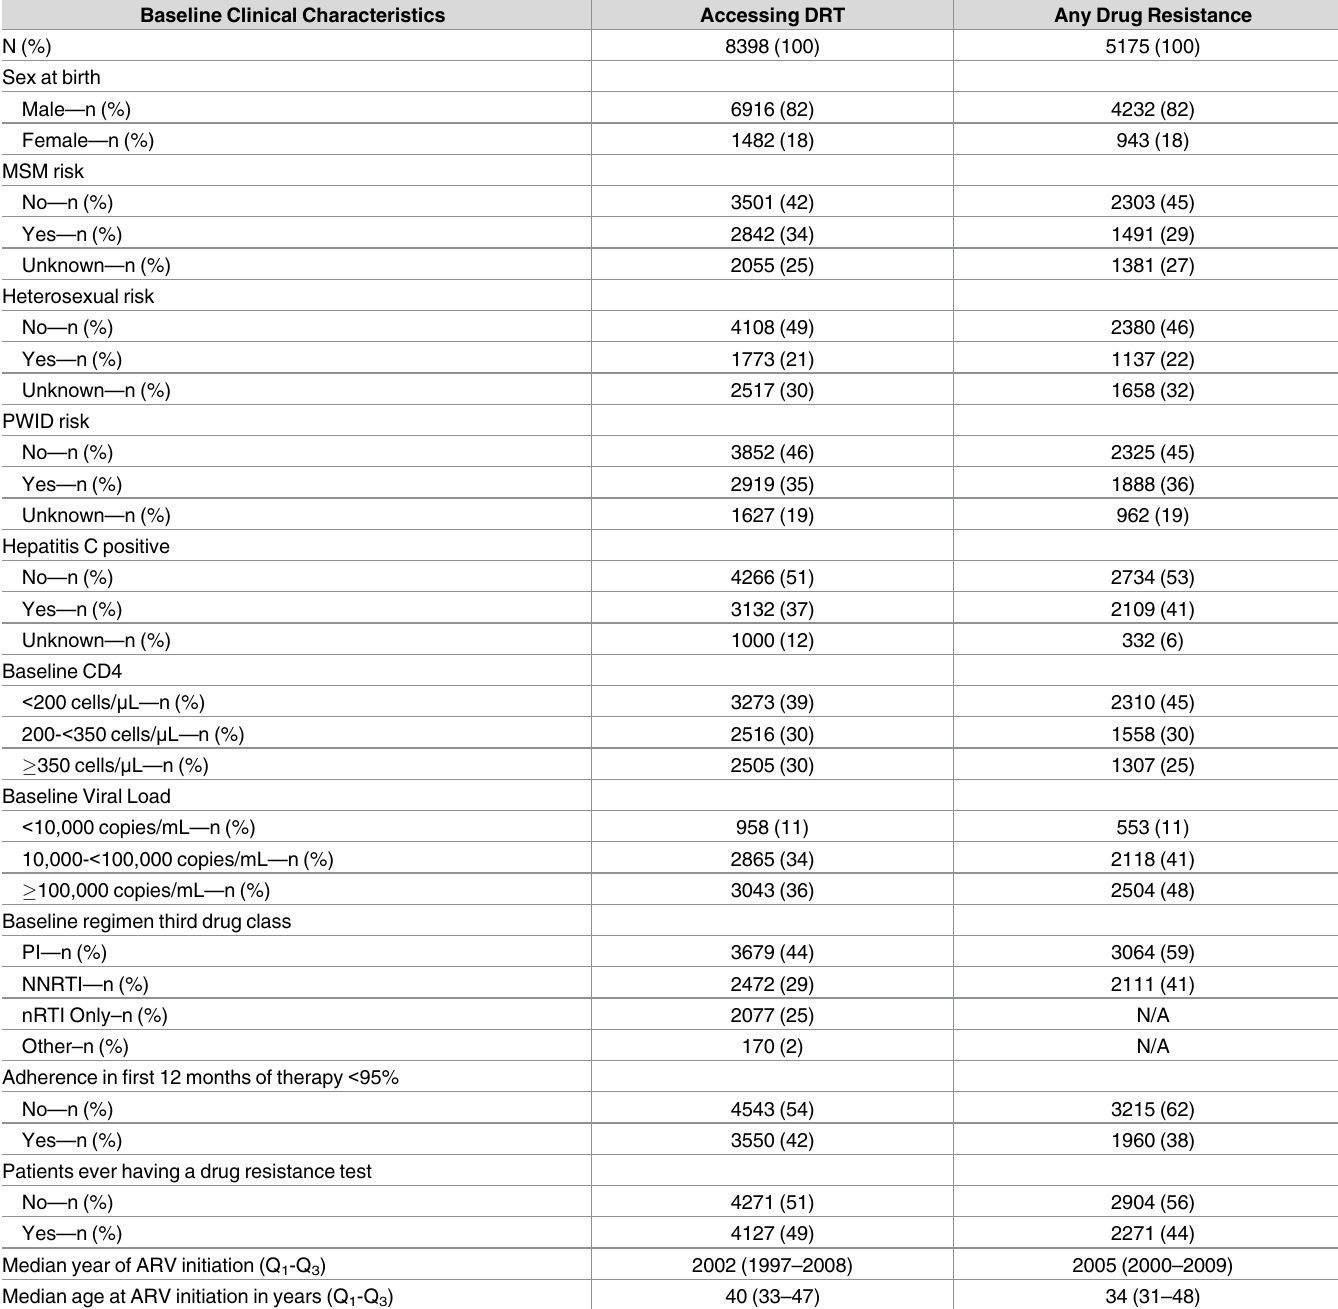
Table 1. Cohort clinical baseline